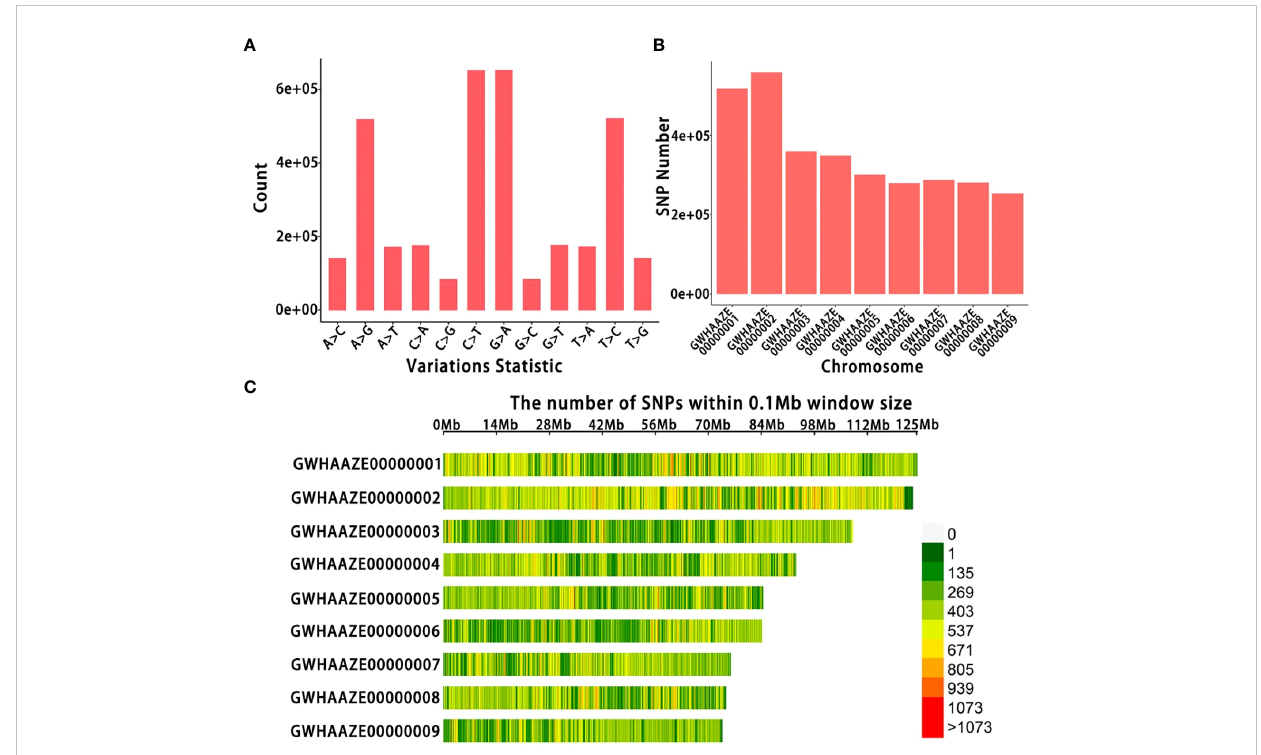
FIGURE 2 Single nucleotide polymorphism (SNP) identi fi cation of 39 Lonicera samples. (A) Number of SNP types. The horizontal axis represents the different types of SNP mutations, and the vertical axis represents the number of mutations. (B) Number of SNPs on each chromosome. The horizontal axis represents the chromosome number, and the vertical axis represents the number of SNPs. (C) SNP density distribution on each chromosome. The horizontal axis represents the chromosome length, and the vertical axis represents the chromosome number. Different colors represent the number of SNPs in different